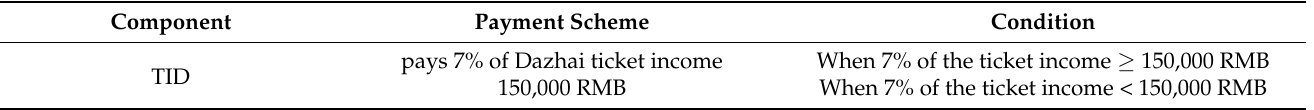
Table 2. The scheme that TID was paid by Longji Tourism Company to Dazhai.